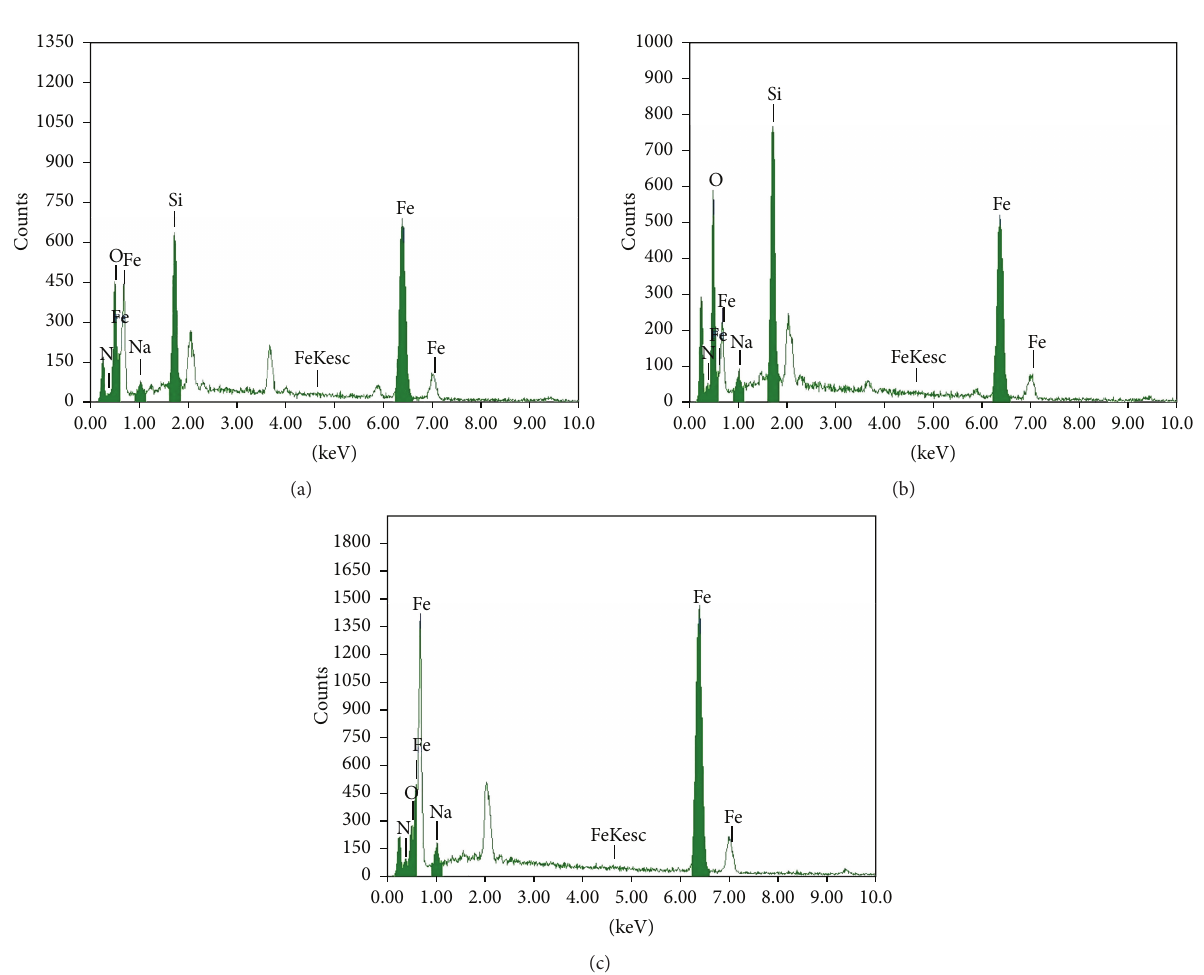
Figure 6: EDS spectrums for the sample at one-step annealing: (a) resin, (b) pore, and (c)